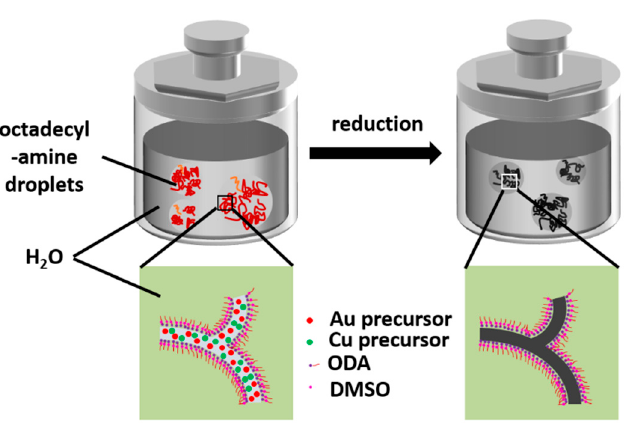
Figure 1. Schematic illustration of the preparation procedure of AuCu.